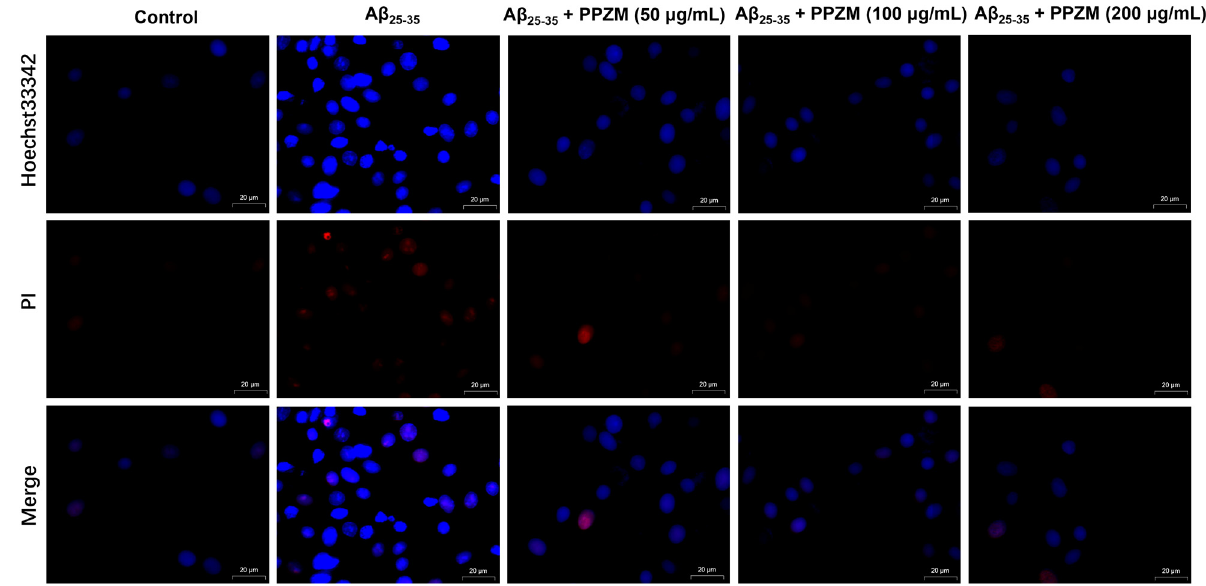
Figure 4. Effects of PPZM on A β 25–35 -induced PC12 cell apoptosis measured by Hoechst/PI staining. The morphological alterations were captured by laser confocal microscope. Scale bars were 20 μ m.